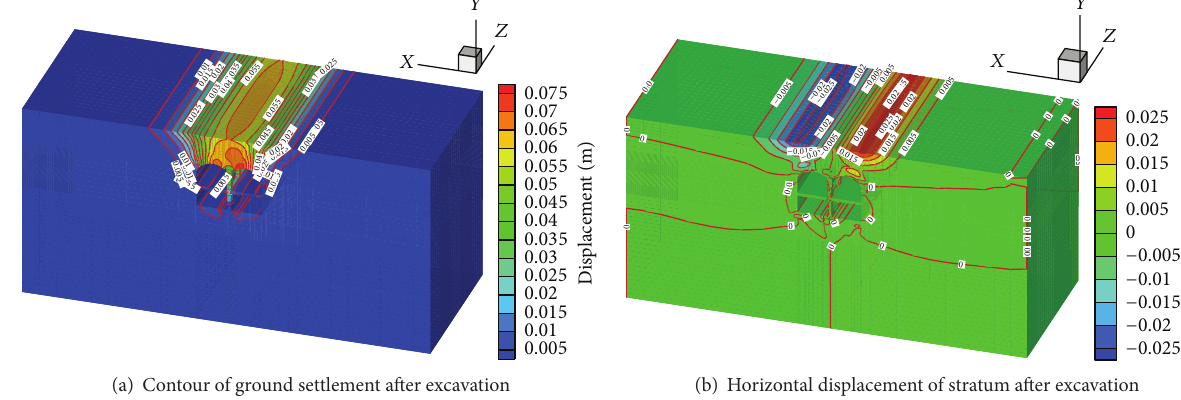
Figure 7: Displacement field obtained from the numerical